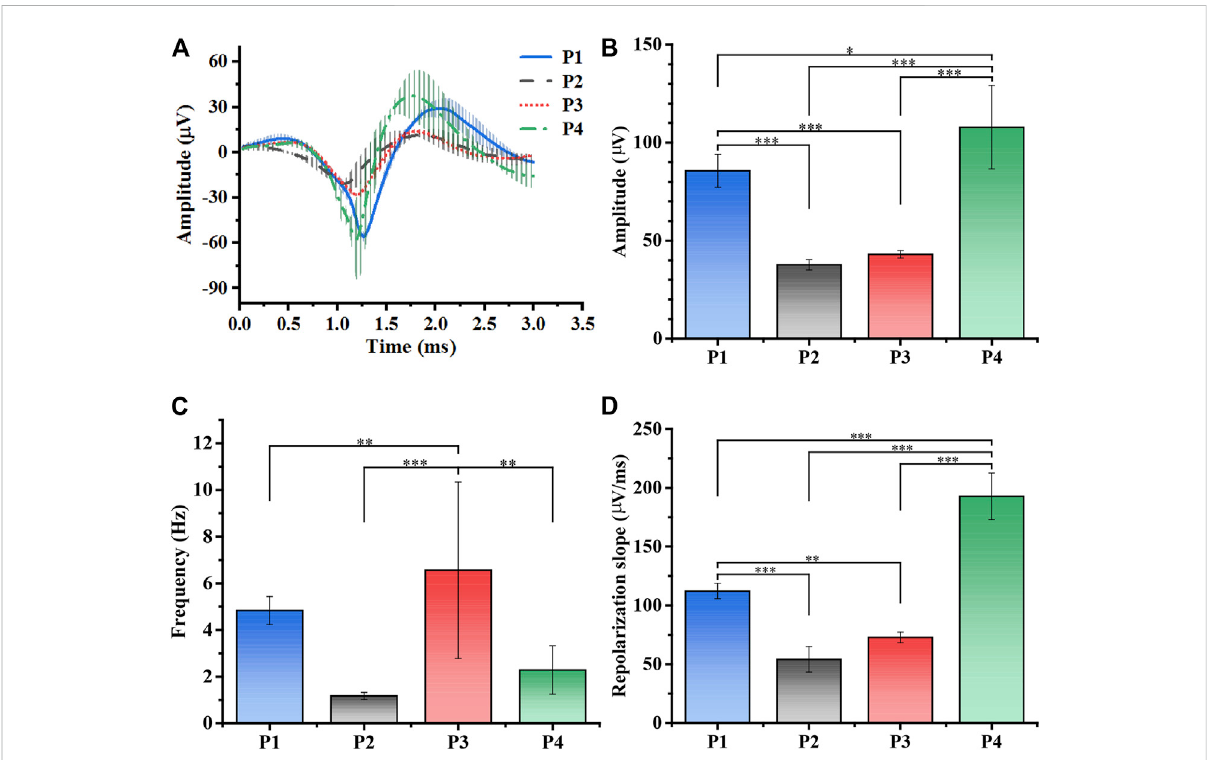
FIGURE 5 Processing and analysis of spikes. (A) The average spike waveforms of SCN in total periods (n = 4, P1: control, P2: torpor, P3 arousal, P4: euthermia). (B) The mean amplitude ( μ V) statistics of spikes waveform in P1-P4 (n = 4, one-way repeated measures ANOVA, * p < 0.05, ** p <